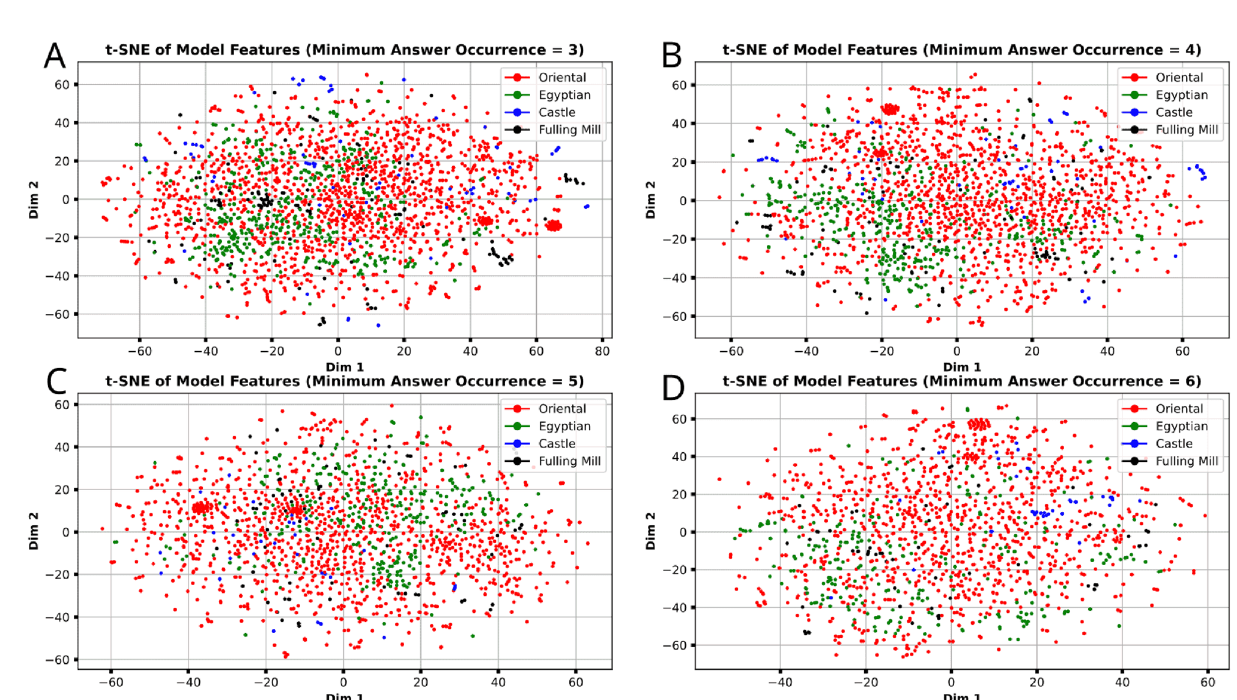
Figure 6. t-SNE Dimension Reduction 25 on the features generated from each image of the dataset, extracted from the penultimate layer of the CNNs used in our